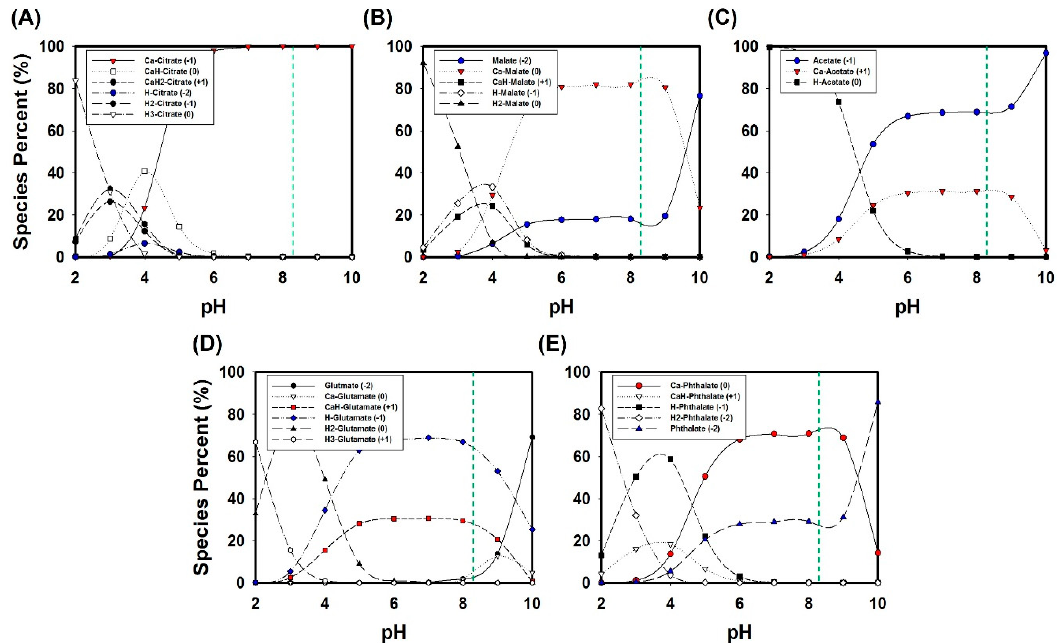
Figure 9. Predominance diagram for organic acid speciation in pre-equilibrated aragonite as a function of pH at the conditions of solution including [Ca 2+ ] initial = 7 mM, [organic acids] initial = 1 mM. ( A ) Citric acid, ( B ) malic acid, ( C ) acetic acid, ( D ) glutamic acid, and ( E ) phthalic acid. The green dashed line is positioned at pH 8.3.